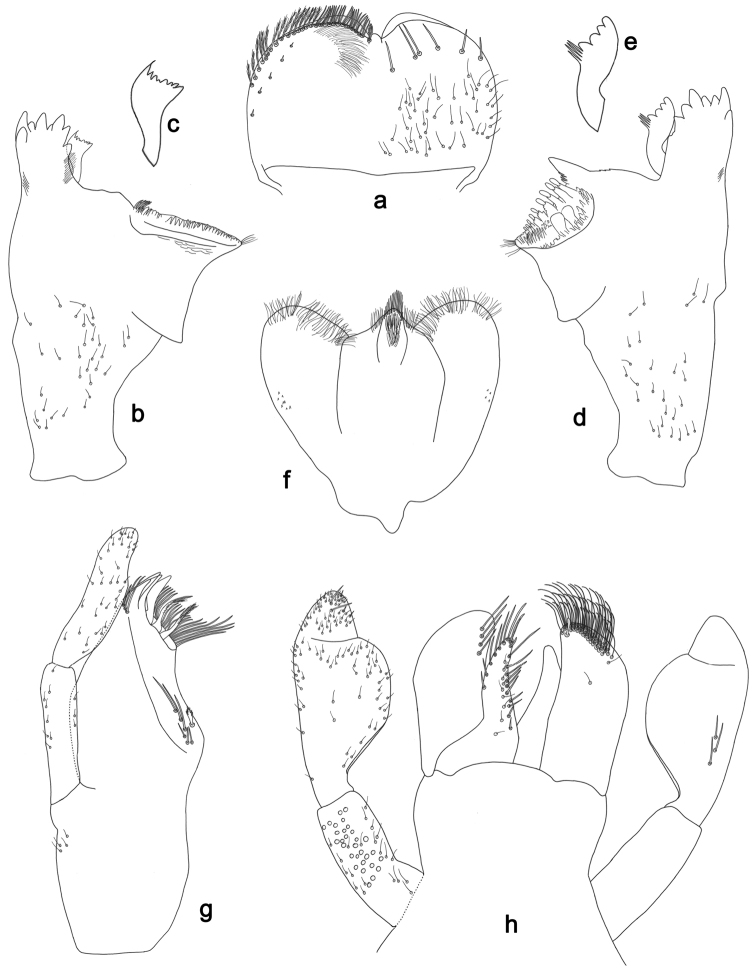
Labiobaetisschwanderae sp. n., larva morphology: a Labrum b Right mandible c Right prostheca d Left mandible e Left prostheca fHypopharynxg Maxilla h Labium.